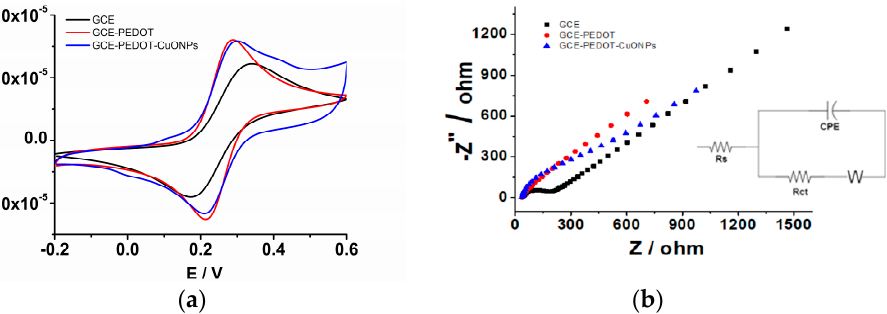
Figure 6. ( a ) CVs recorded for the naked GCE (black line), GCE/PEDOT (red line), and GCE/PEDOT-CuONPs (blue line) in an aqueous solution containing 5 mM Na 4 [Fe(CN) 6 ] and 0.5 M KNO 3 . Potential scan rate: 50 mV/s. ( b ) Electrochemical impedance spectra recorded for the naked GCE (full rectangles), GCE/PEDOT (full circles), and GCE/PEDOT-CuONPs (full triangles) in an aqueous solution containing 5 mM Na 4 [Fe(CN) 6 ]/K 3 [Fe(CN) 6 ] and 0.5 M KNO 3 . Inset: the electrical equivalent circuit used in the fitting of the EIS data.